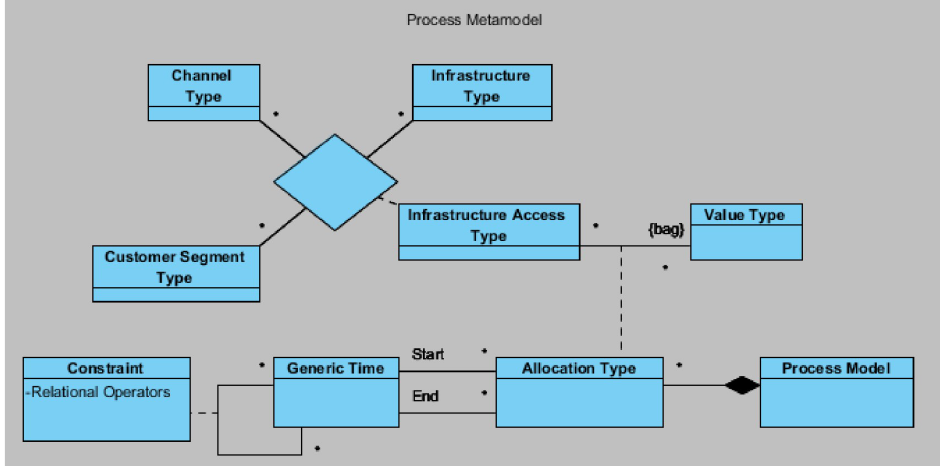
Figure 2. UML class diagram of the Process